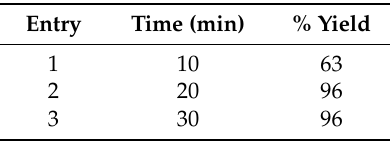
Table 5. Milling of 2.5 g of o -phenylenediamine and 1.5 g of urea with 56.6 g of balls at 20 Hz.